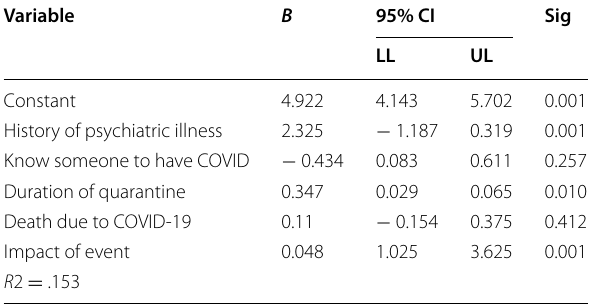
Multiple linear regression analysis showing that history of psychiatric illness and impact of life events explained 39% variance for depression [ F (5,314) p <